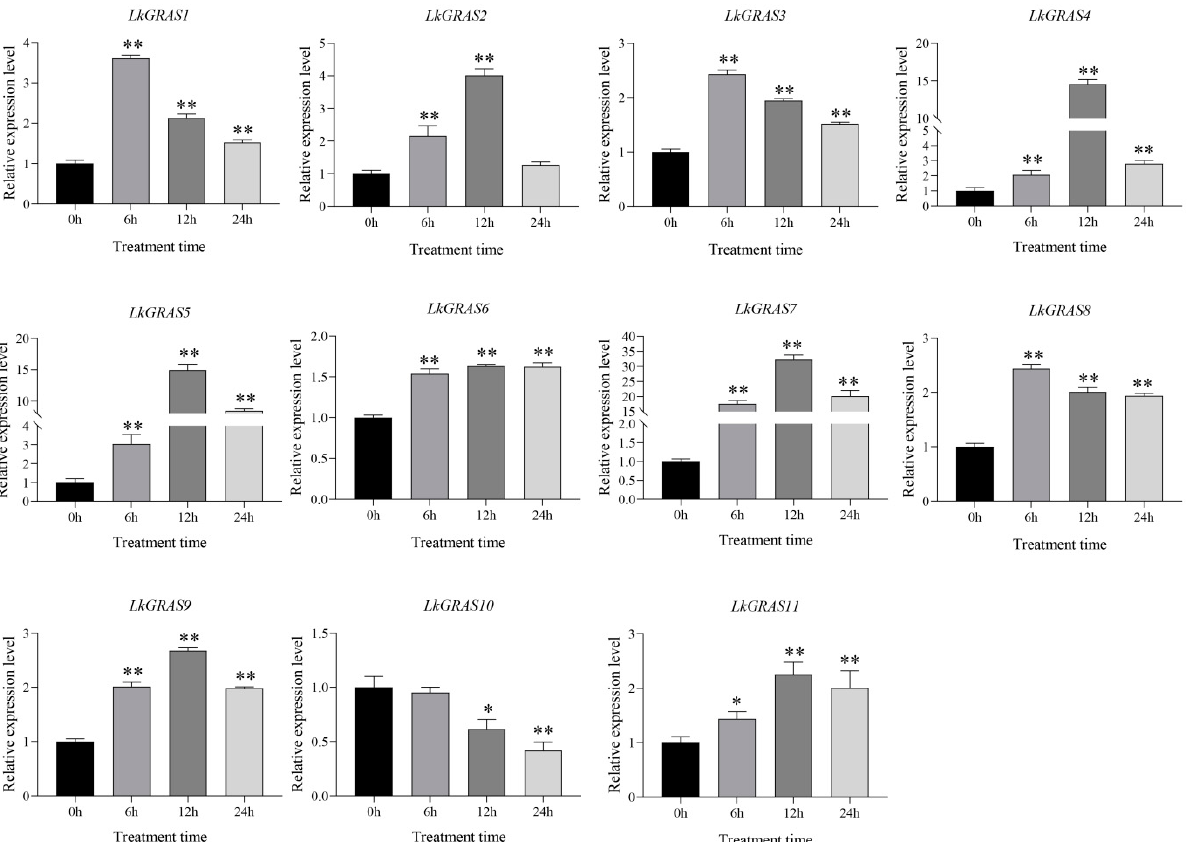
Figure 5. The relative expression level of the LkGRAS genes in needles under GA 3 treatment using qRT-PCR. Error bars represent the deviations from three biological replicates. The x -axis represents the time points after 100 µ M GA3 treatment (* p < 0.05, ** p <